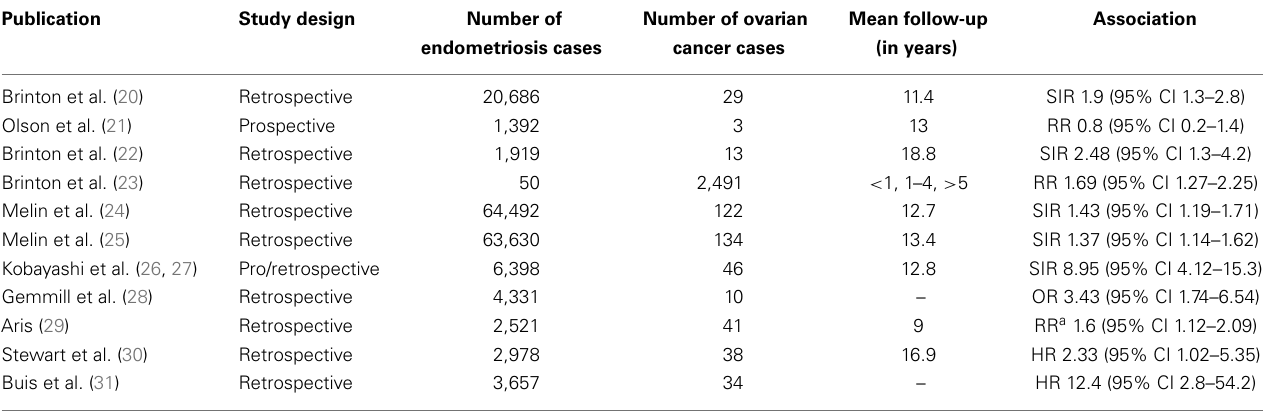
Table 2 | Overview of cohort studies assessing the association between endometriosis and ovarian cancer